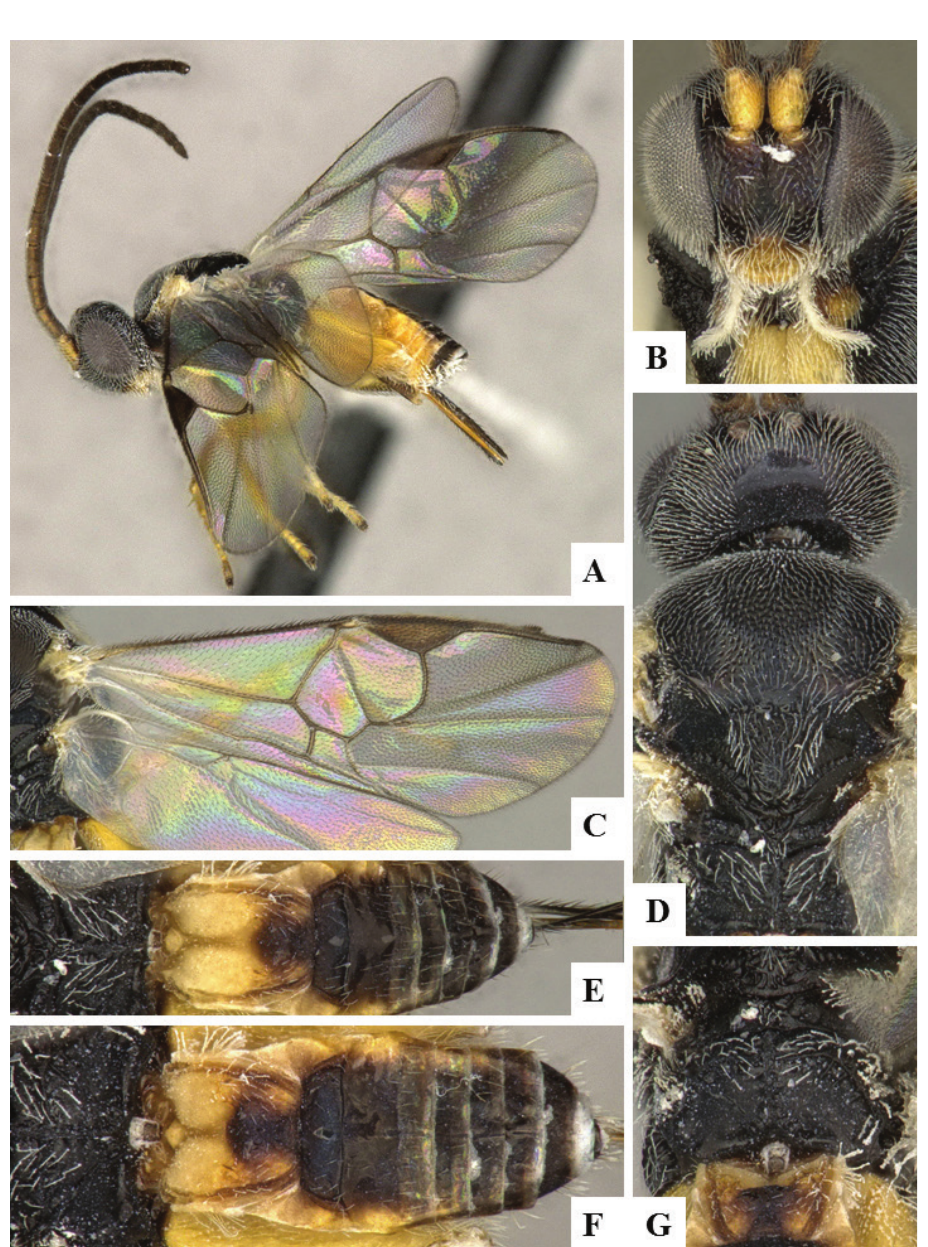
Figure 15. Janhalacaste guanacastensis female holotype. A Habitus B Head frontal C Fore wing and hind wing D Head and mesosoma, dorsal E Metasoma dorsal F Tergites 1 to 2 G Propodeum. ior margin; sometimes T3-T6 with small yellow spots laterally); metasoma most- ly yellow laterally and ventrally; scape and pedicel yellow, flagellomeres mostly brown; palpi white; legs yellow; wings with veins mostly brown. Head,